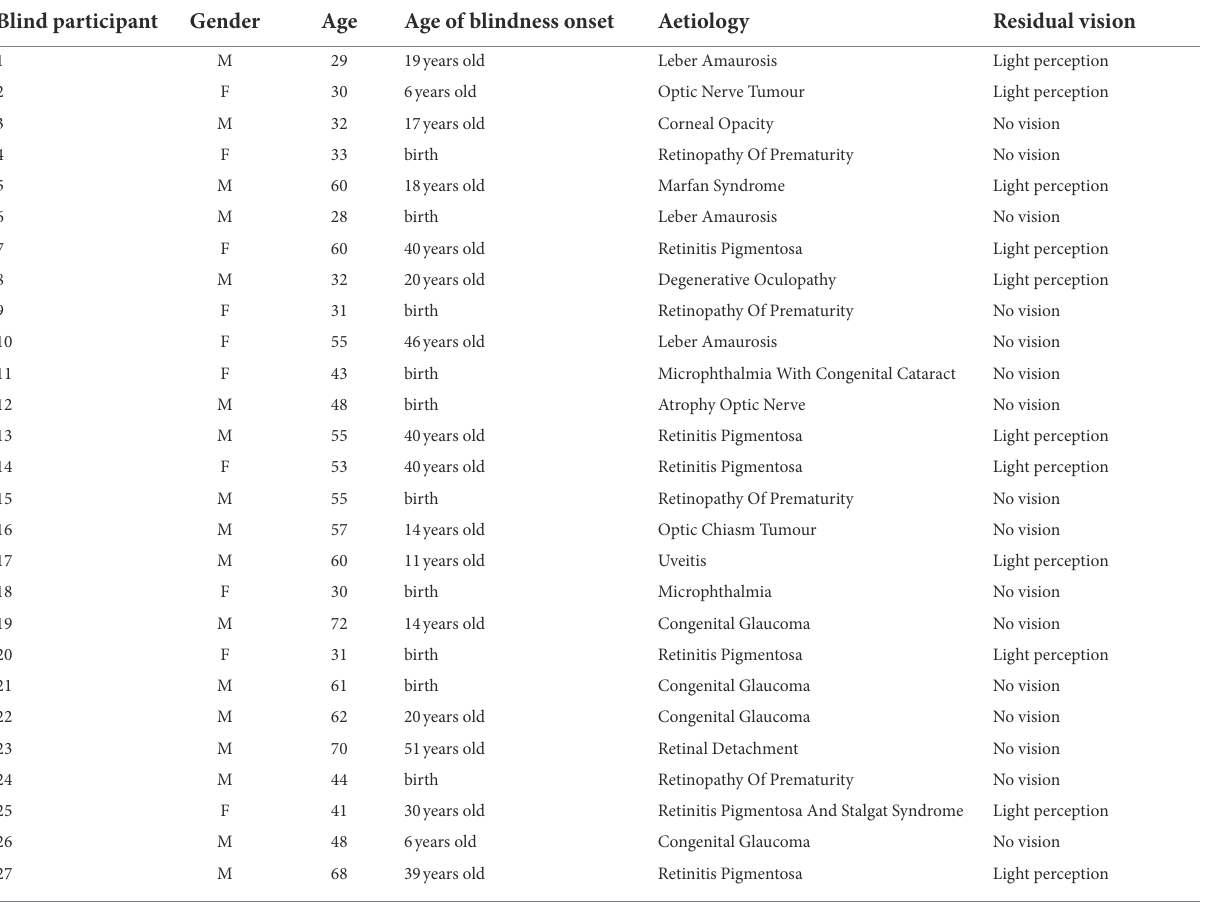
TABLE 1 Clinical details of blind participants. Blind